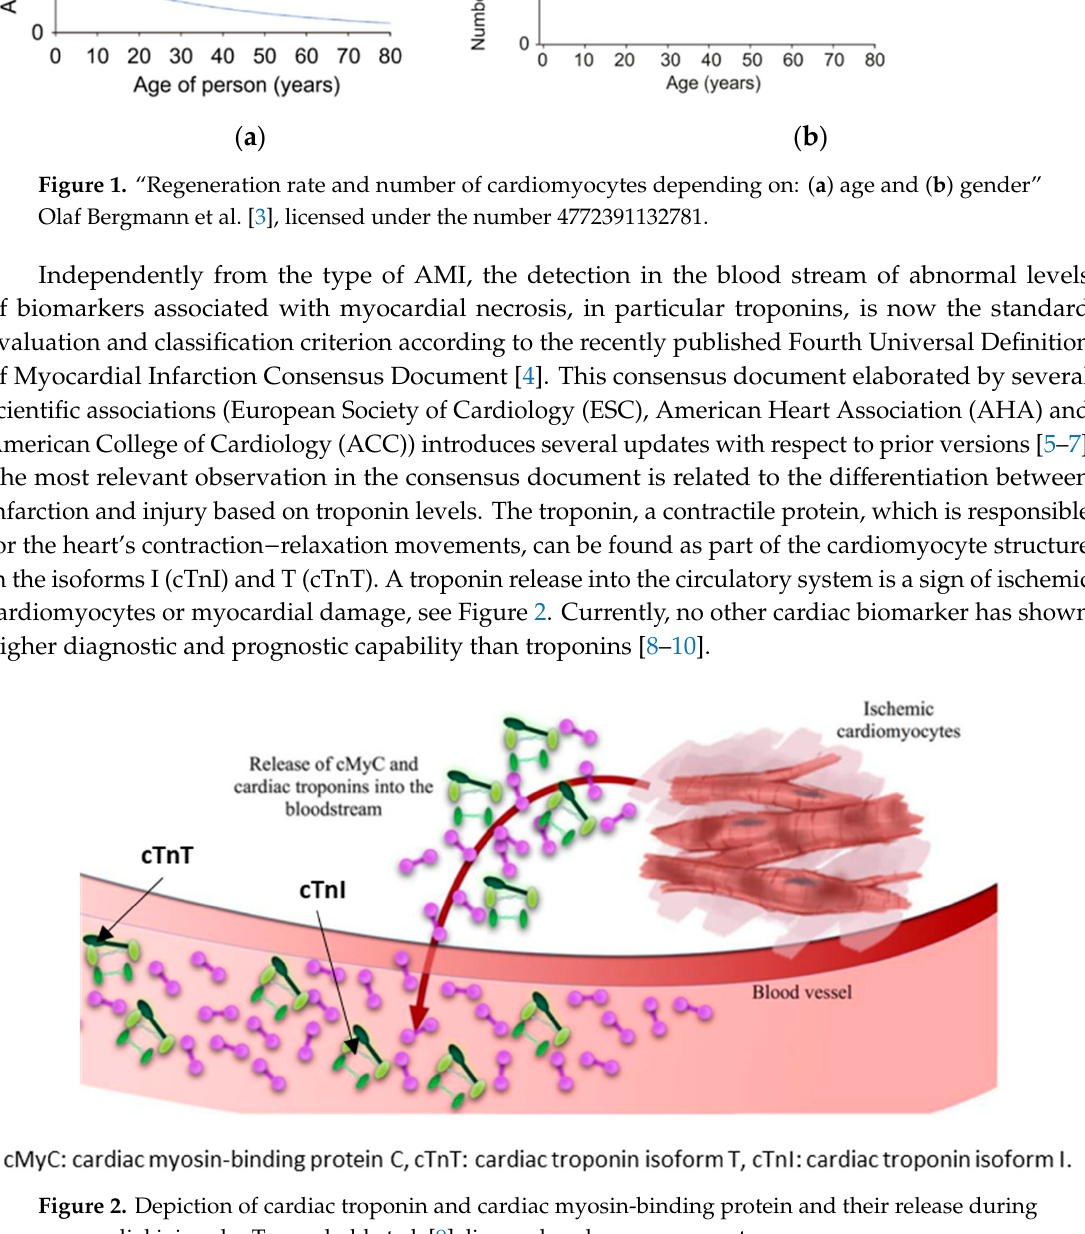
Figure 2. Depiction of cardiac troponin and cardiac myosin-binding protein and their release during myocardial injury by Twerenbold et al . [9], licensed under open access terms.